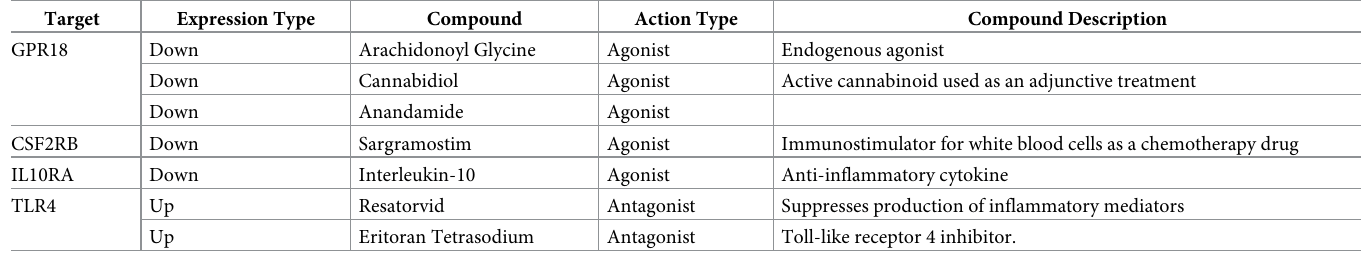
Table 5. The results of drug screening that targets biomarker proteins identified a result of clustering analysis. The expression type column shows gene expression change of the gene. The action type was chosen according to the expression status of a target.